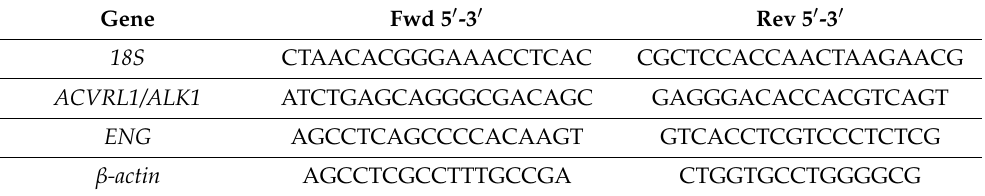
Table 1. Primers used for q-PCR